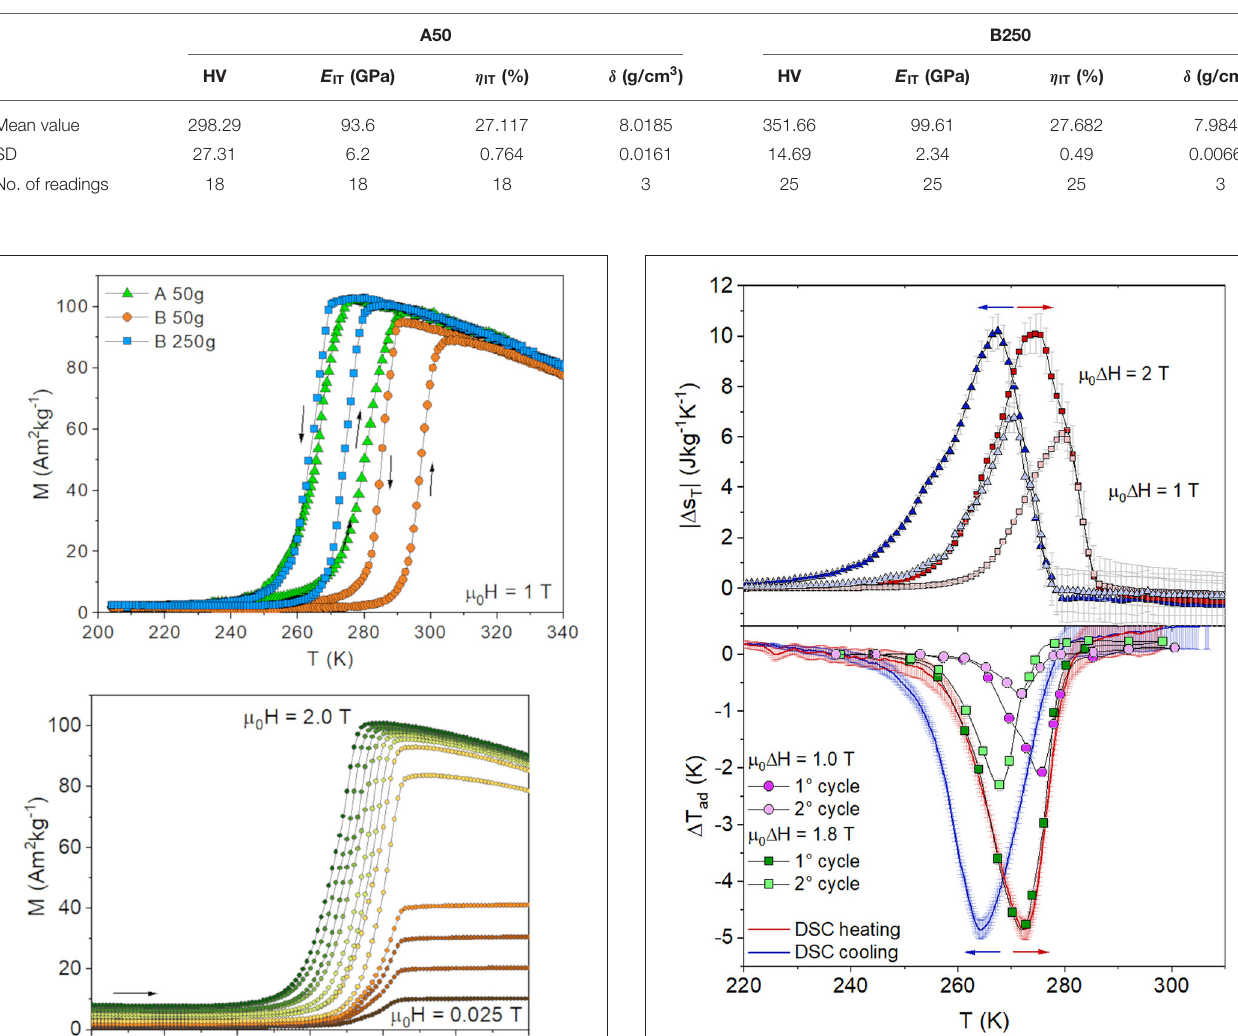
TABLE 4 | Summary of the measured mechanical properties for A50 and B250; meanvalues, standard deviations, and number of readings are displayed.